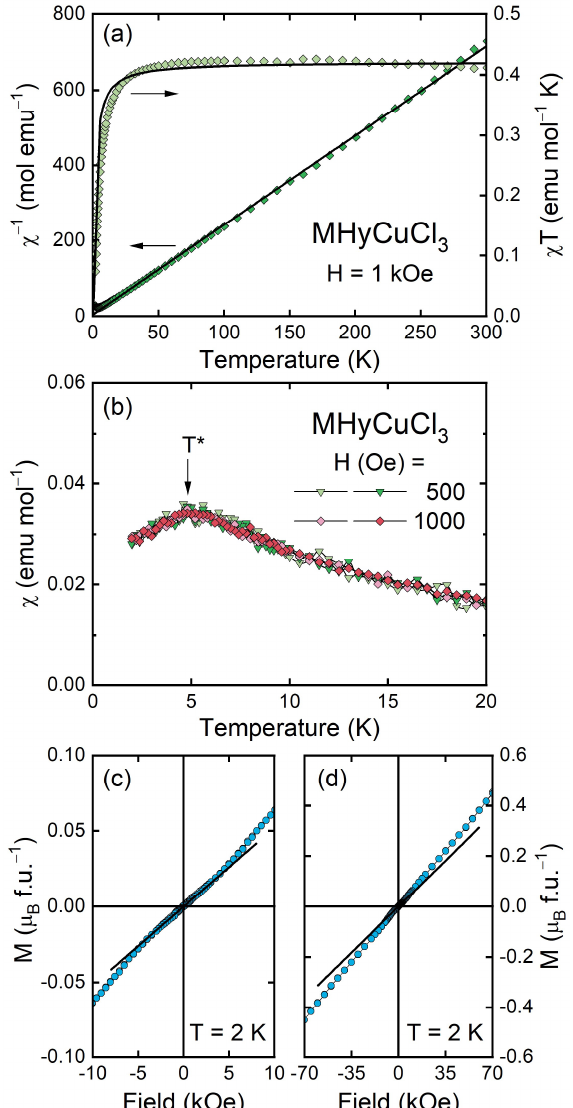
Figure 5. ( a ) χ −1 ( T ) and χT ( T ) (left and right axis, respectively) of MHyCuCl 3 plotted with the fitted Curie–Weiss formula (solid curves). ( b ) χ ( T ) measured in the ZFC and FC regimes (bright and dark symbols, respectively); the arrow marks a characteristic temperature T * . ( c , d ) M vs. H plotted in two different field ranges; solid lines show linear M ( H ) dependence in low fields.